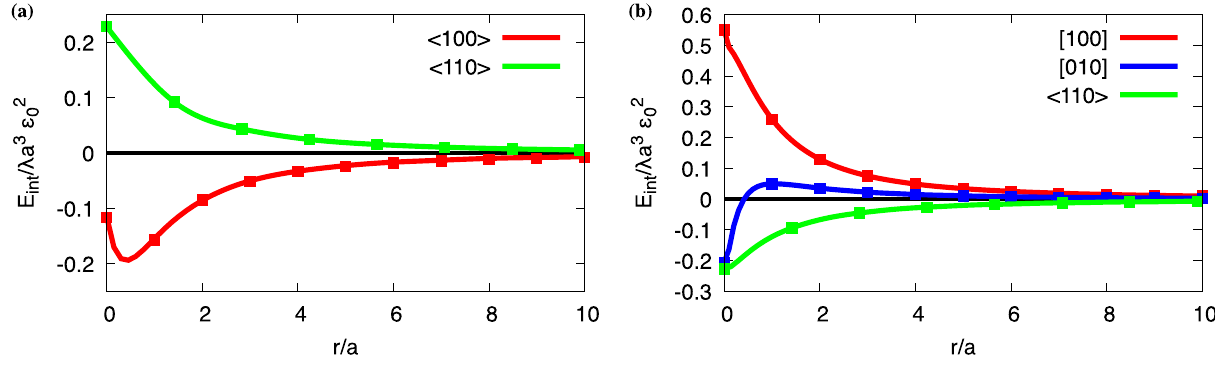
s j ). Interaction energies in the case of Figure 2. Interaction energies of two grains of equal variant type ( s i = ( a ) shear eigenstrain and vanishing average stress and ( b ) tetragonal eigenstrain. The interaction energy per 3 ε 2 50 , length is given in units of (cid:31) a 0 , and the computations were done using a system size of L x / a = L y / a = 0 the grains touch each other. The symbols on the where a is the edge length of the grains. At distance r / a = continuous curves indicate the information for the interaction at discrete lattice sites, which is actually used in the annealer